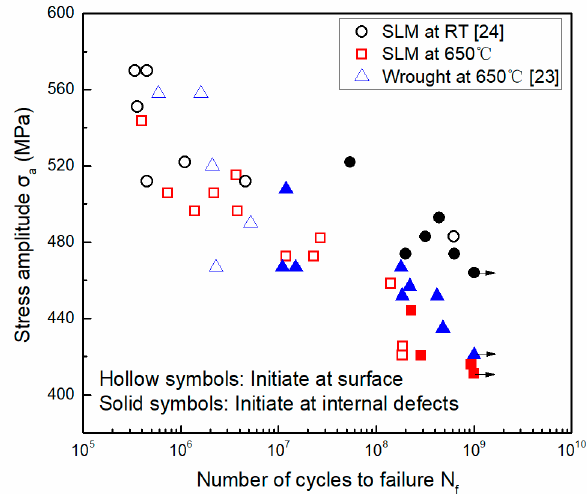
Figure 6. S-N curves of SLM and wrought specimens tested at RT and 650 °C. The S-N curves of SLM alloy at RT and wrought material at 650 °C are cited from the author’s previous publications [23,24]. Adapted with permission from ref. [23]. Copyright 2020 Nanjing University of Aeronautics and Astronautics., Adapted with permission from ref. [24]. Copyright 2020 Shanghai Research Institute of Materials